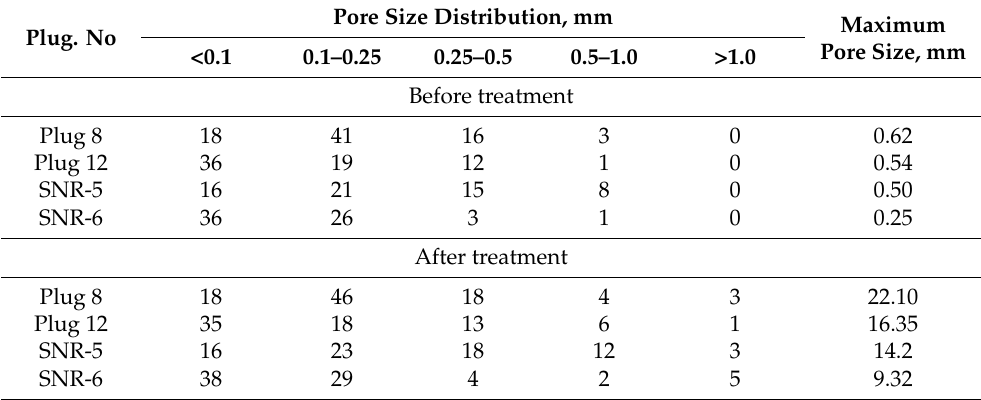
Table 5. Pore size distribution before and after injection of CO 2 foamed